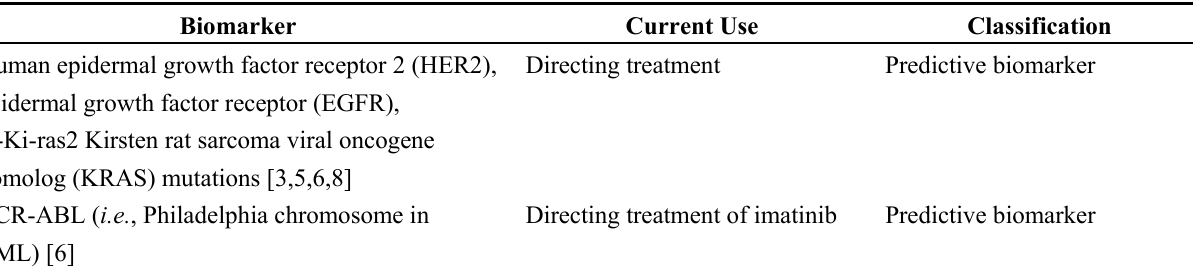
Table 1. Examples of biomarker